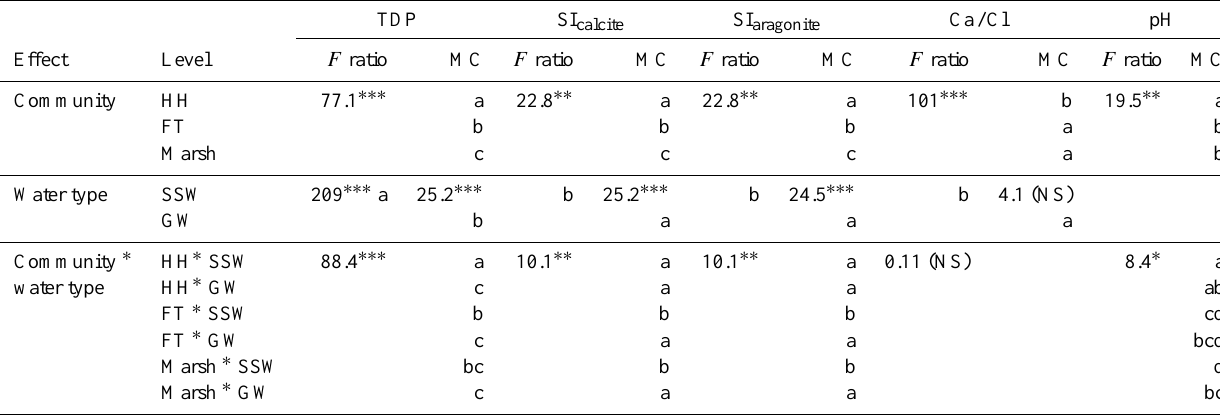
Table 2b. Multivariate analysis of variance using a mixed effects model structure of summary hydrogeochemical parameters by community (High Head – HH, Far Tail – FT and Marsh) and water type, with water type categorized by depth: shallow soil water (SSW – 0.3 and 0.6m) and groundwater (GW-2 and 8m). TDP SI calcite SI aragonite Ca/Cl pH